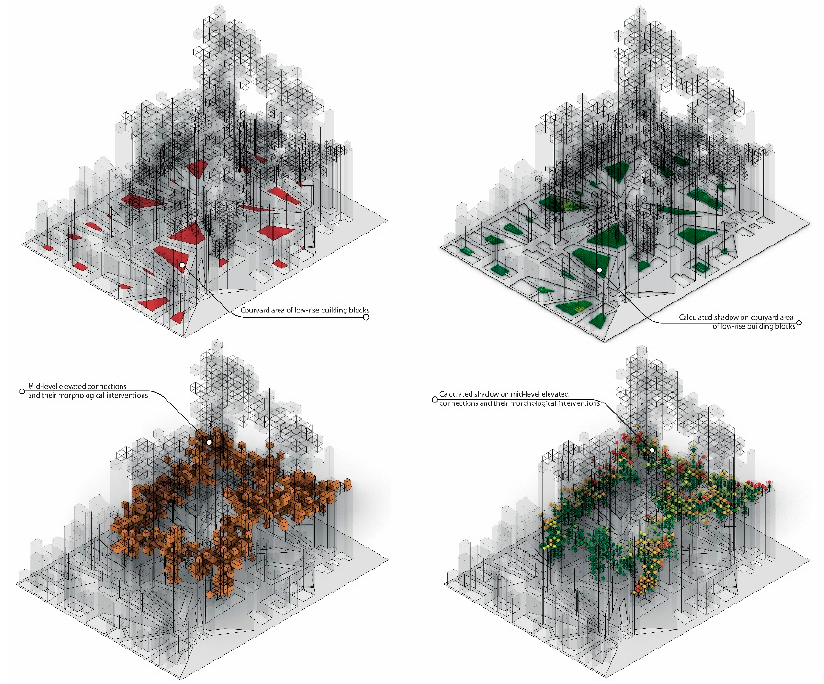
Figure 10. Fitness Function 1: Solar gain calculation on the different morphological characteristics of the superblock.